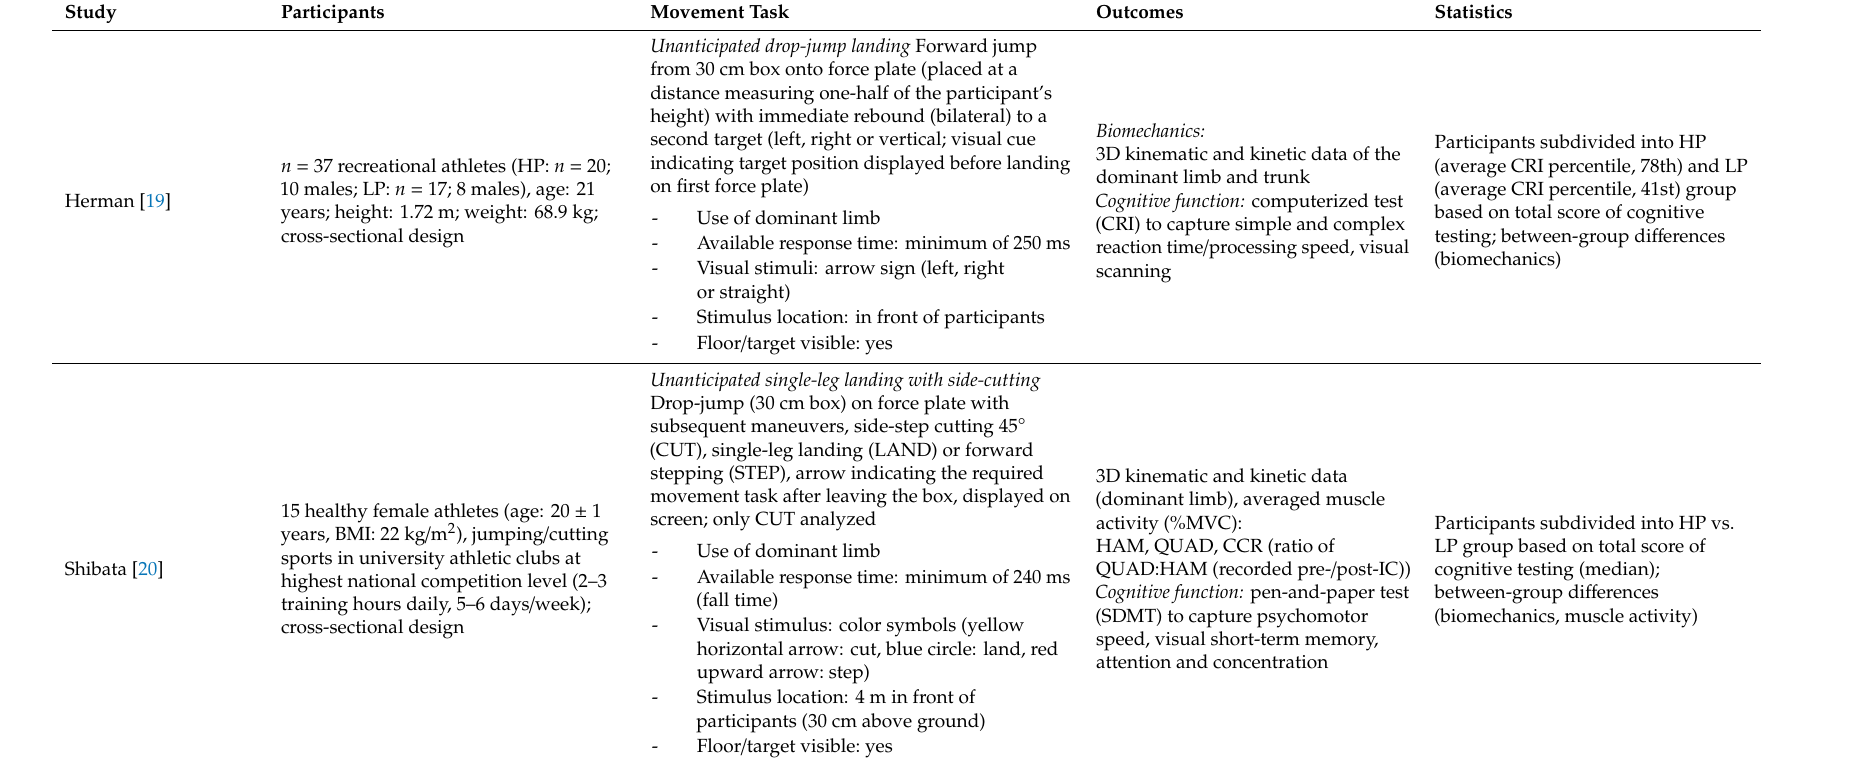
Table 1. Characteristics of the included